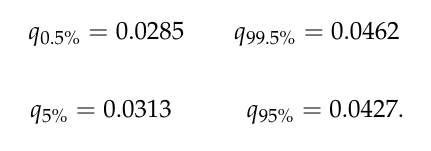
Figure 7. Case (c): probability distribution of the distance between Dollar and Euro ( left ) and rejection areas for α = 0.995 (green) and α = 0.95 (yellow) ( right ).